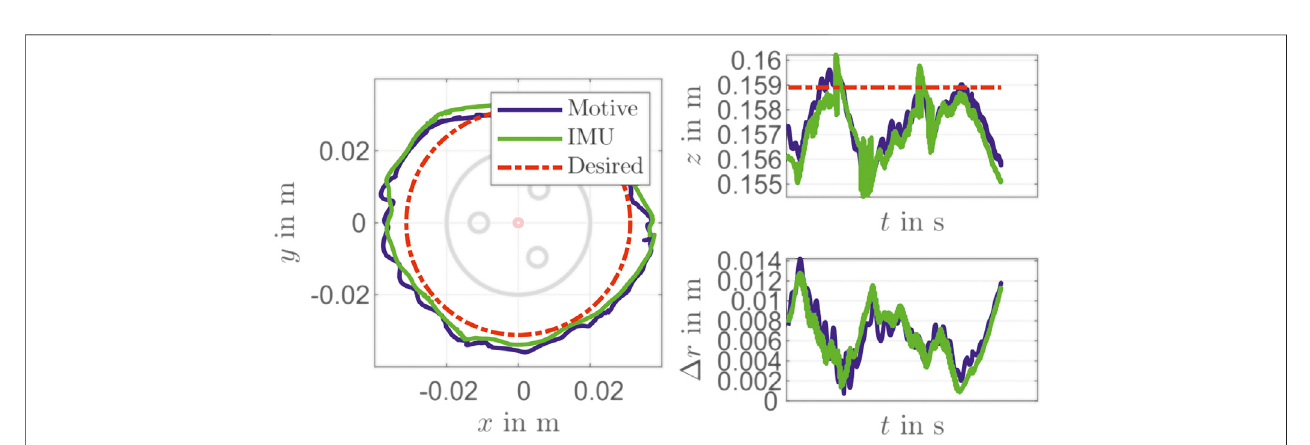
FIGURE 11 | Movement in a circular path in T (cid:1) 100s.